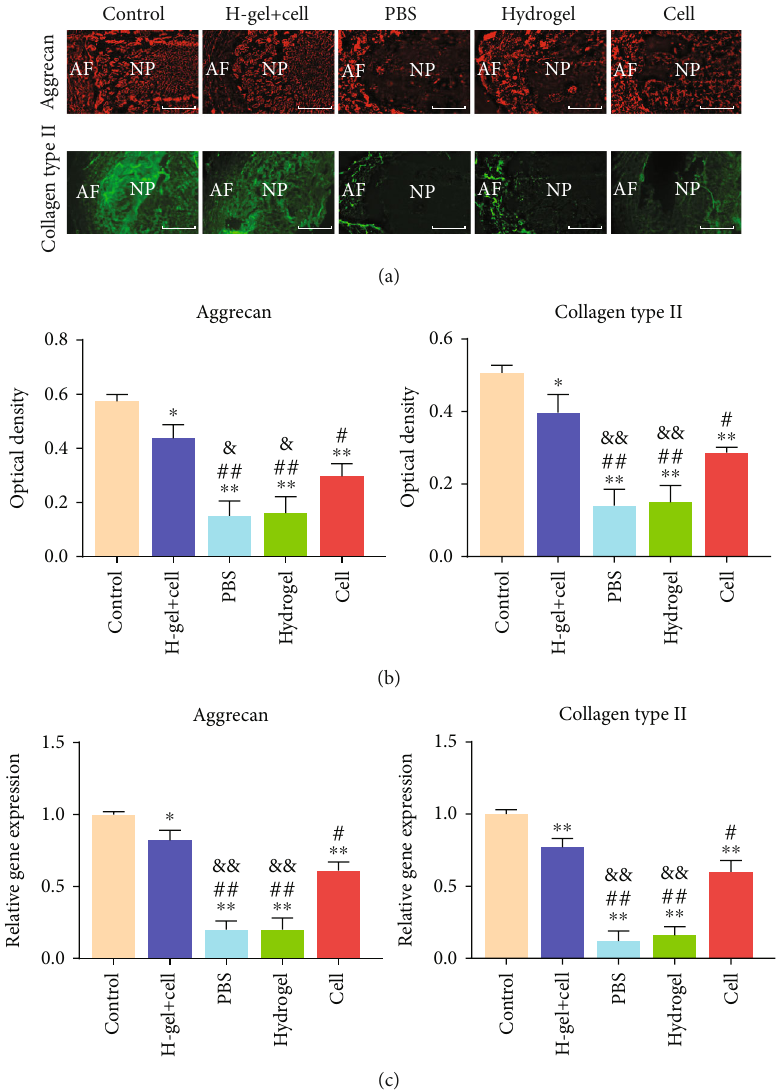
Figure 11: Immuno fl uorescence and RT-PCR of di ff erent groups. (a) Immuno fl uorescence detection of collagen type II and aggrecan of di ff erent groups at 8 weeks after injection. (b) The quantitative analysis of immuno fl uorescence staining. (c) Gene expression of collagen type II and aggrecan of di ff erent groups at 8 weeks after injection. Data represent mean ± SD ; the error bars represent the standard deviation of measurements for 3 separate samples ( n = 3 ); ∗ p < 0 : 05 , ∗∗ p < 0 : 01 compared with control group; # p < 0 : 05 , ## p < 0 : 01 compared with hydrogel+cell group; & p < 0 : 05 , && p < 0 : 01 compared with cell